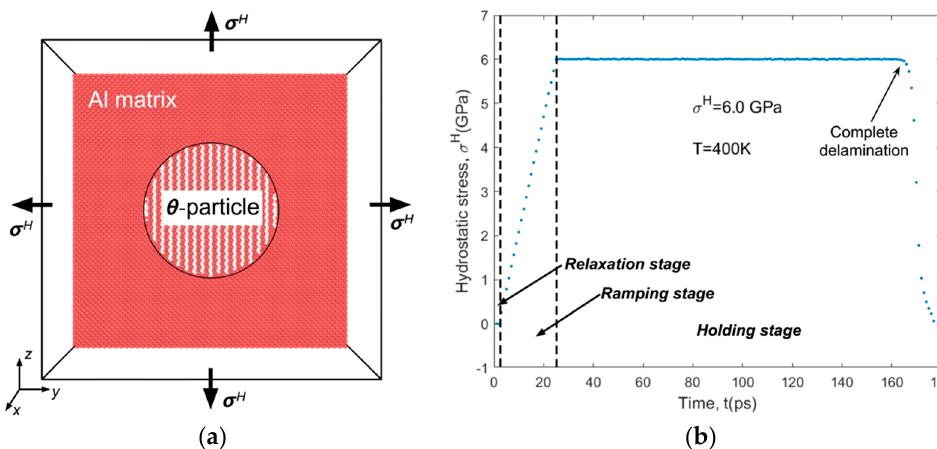
Figure 1. Simulation details. ( a ) Snapshot showing periodic simulation cell with a spherical θ -particle loaded hydrostatically; ( b ) time history of hydrostatic stress from a sample simulation at T = 400 K and σ H = 6.0 GPa with simulation stages marked. When the particle completely delaminates the applied stress can no longer be sustained, causing the precipitous drop at the end.